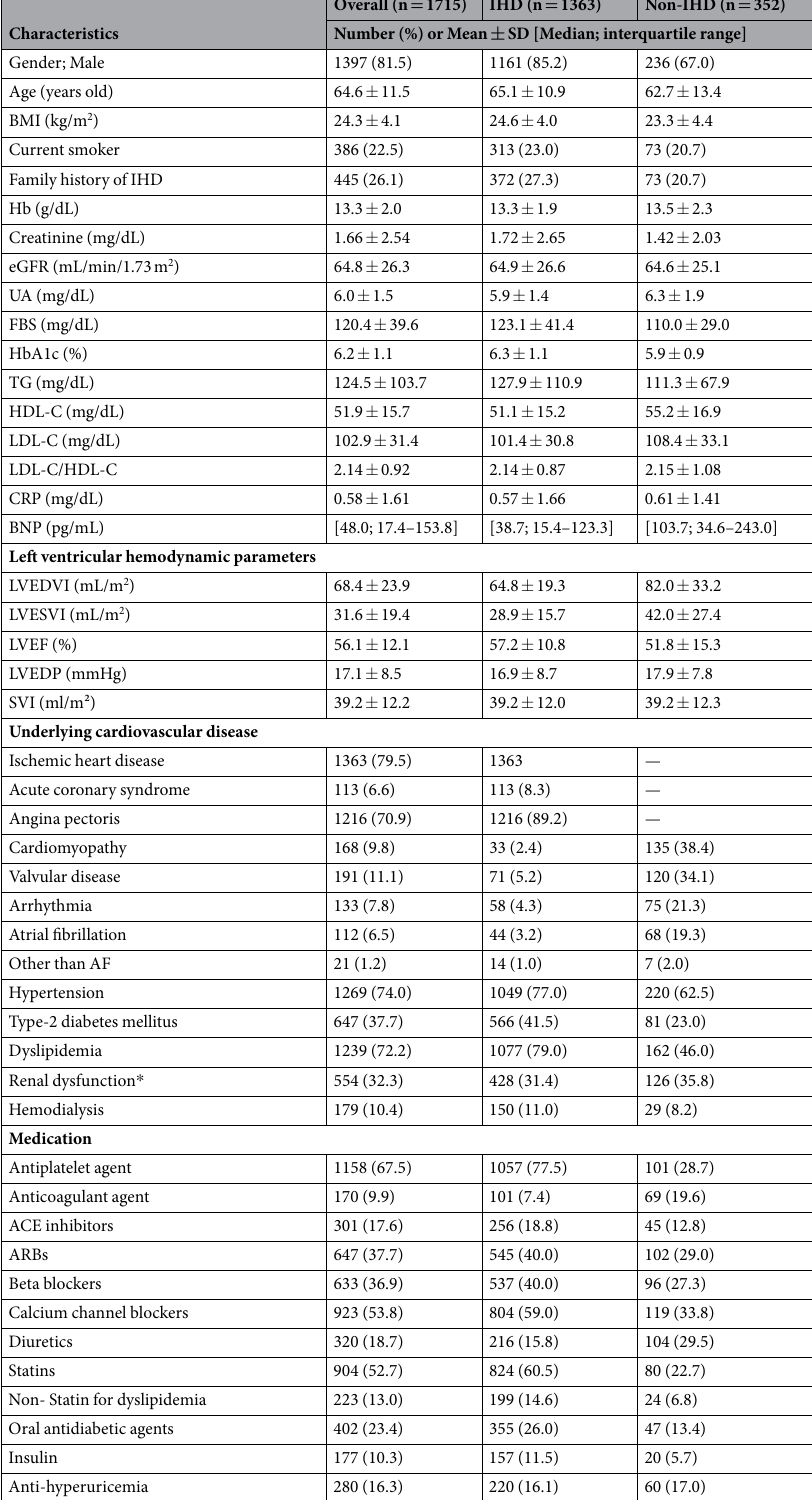
Table 1. The characteristics of all patients. Hb, hemoglobin; UA, uric acid; FBS, fasting blood sugar; HbA1c, hemoglobin A1c; TG, triglycerides; HDL-C, high-density lipoprotein; LDL-C, low-density lipoprotein;